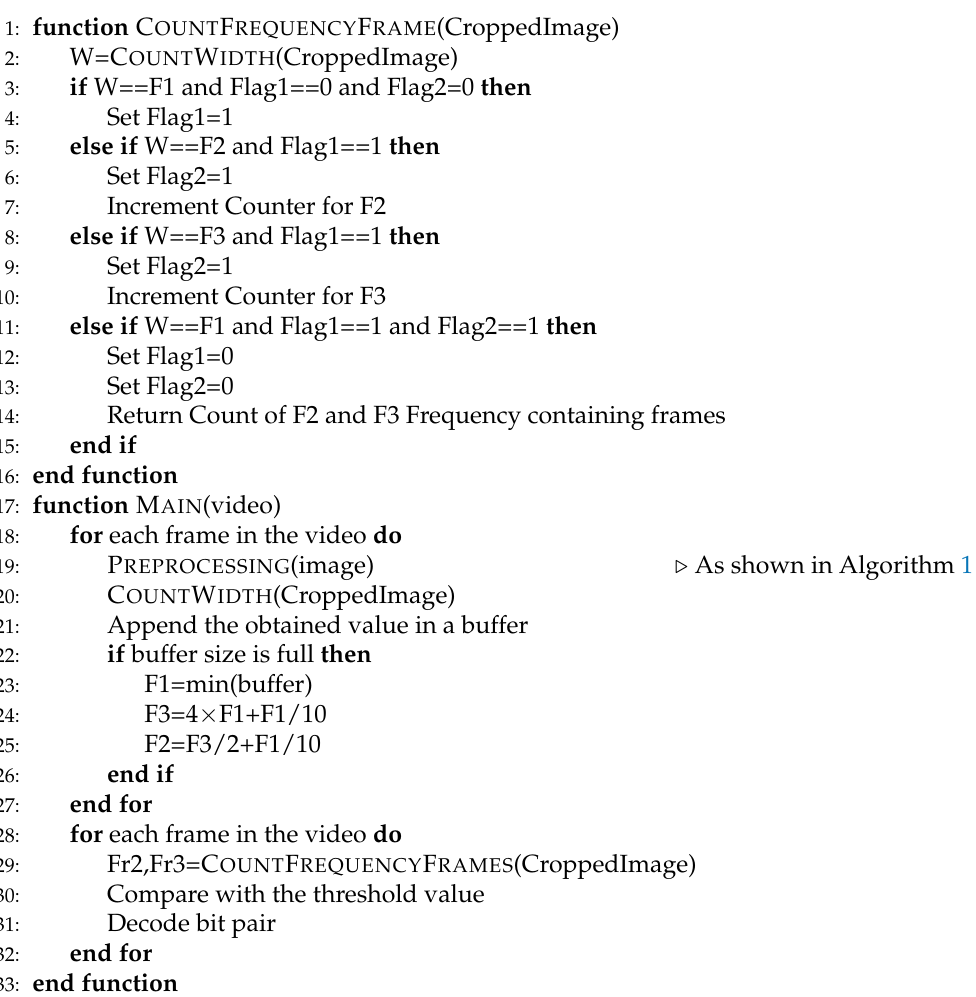
Algorithm 7 HFSPDM Demodulation for VLC-OCC